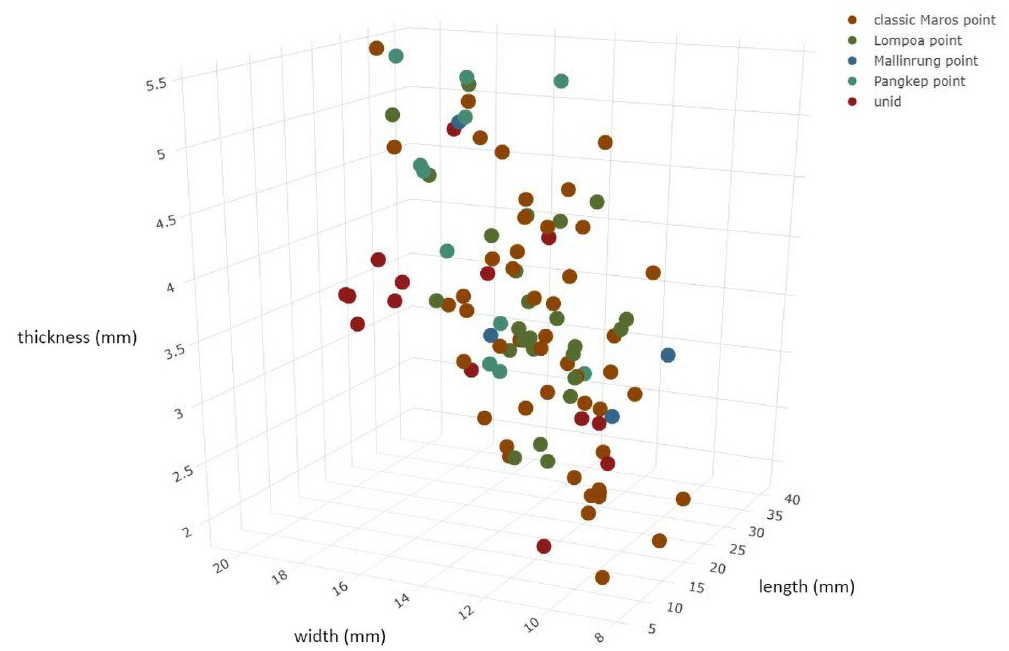
Fig 17. Maros point dimensions by type. 3D scatterplot of the dimensions of 102 unbroken point types, illustrating a similar range of sizes across all point types.